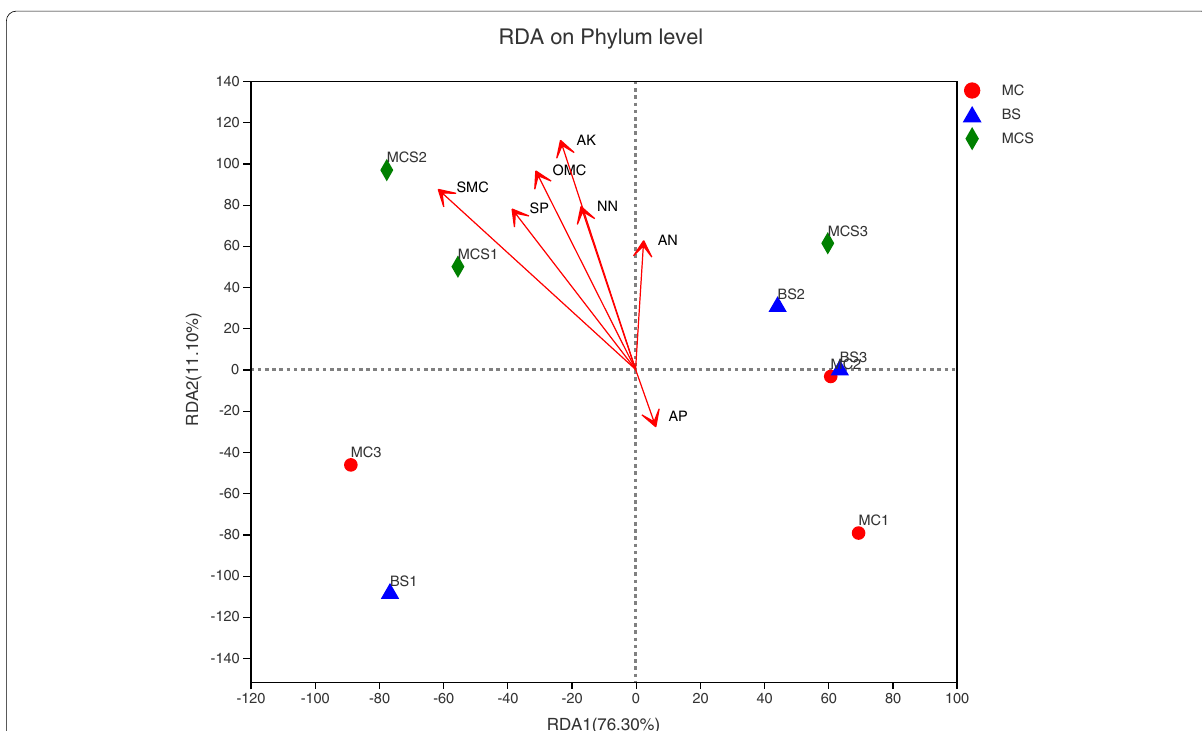
Fig. 8 RDA ordination plots showing the relationship between the bacterial community structure and physical and chemical properties. Notes: MC, BS, and MCS are the same as in Fig.